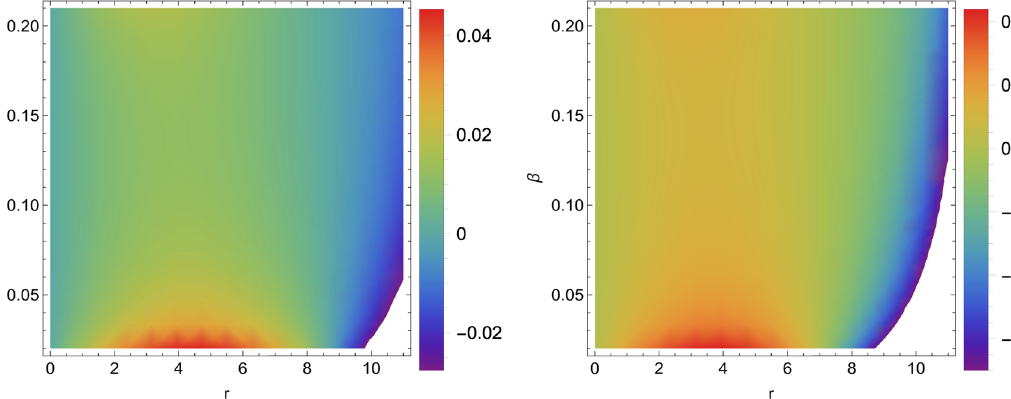
Fig. 12 The distribution of energy exchange ( (cid:4) E ) on ( r − β ) plane for A 2 = − 0 . 5 (left panel) and A 2 = − 0 . 75 (right